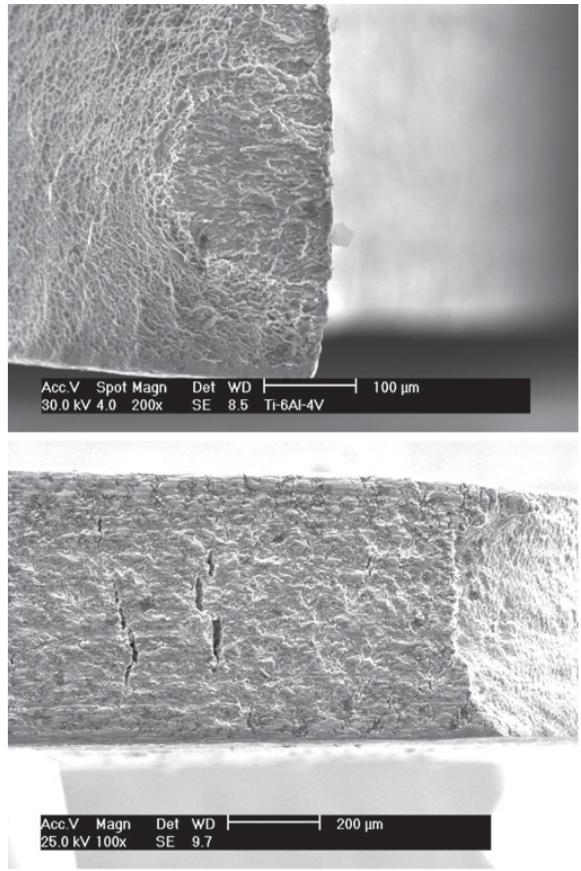
Fig. 6. Top: Edge crack found on the fracture surface of a sample after fatigue failure. Bottom: Similar cracks along the edge of the sample.